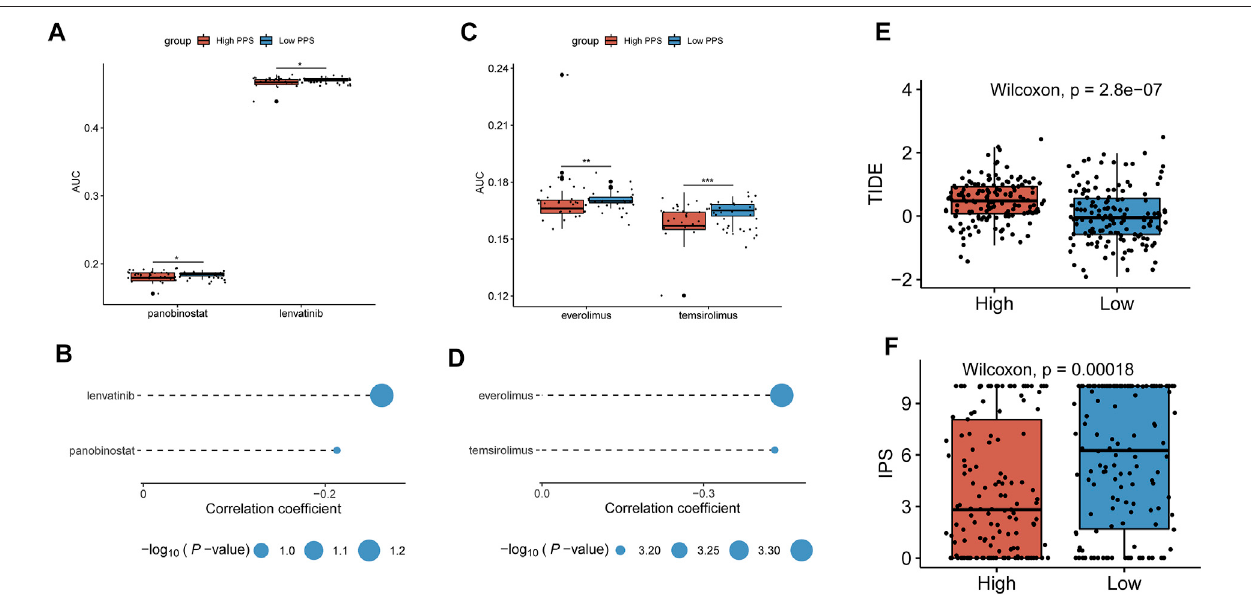
FIGURE 8 | Identi fi cation of potential agents and prediction of immunotherapeutic effect. (A,B) Differential drug response analysis of the selected agents for CC patientsbetweenthehigherandlowerriskscoregroupsbasedontheCTRPdatasetandSpearman ’ scorrelationanalysisofCTRP-derivedagentsand riskscore. (C,D) Differential drugresponseanalysisofthe selected agents for CC patients betweenthe higher and lower riskscoregroups based on thePRISM dataset and Spearman ’ s correlationanalysisofPRISM-derivedagents andriskscore. (E,F) TheTIDEscoreandIPSwerecompared betweenthehigh-andlow-riskgroups. * p < 0.05;** p < 0.01; *** p < 0.001; ns, not signi fi